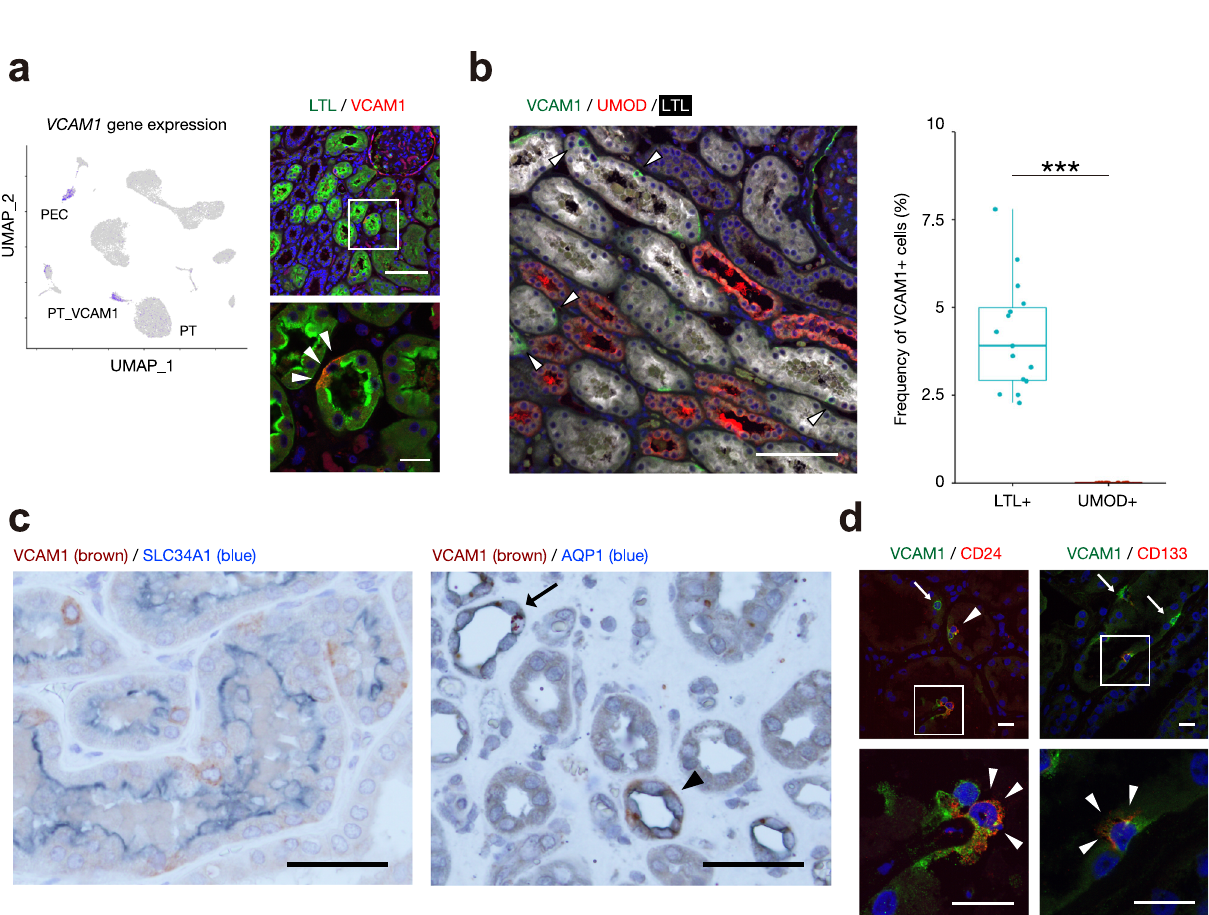
Fig. 5 Identi fi cation of a subset of proximal tubular cells that express VCAM1 . a Umap plot displaying VCAM1 gene expression in the snRNA-seq dataset (left), and representative immunohistochemical images of VCAM1 (red) or LTL (Lotus tetragonolobus lectin, green) in the adult kidney ( n = 3 patients). Arrowheads indicate the VCAM1 + proximal tubular cells. VCAM1 was expressed in PEC and a subpopulation of LTL + proximal tubular cells. Scale bar indicates 100 µ m (upper right) or 20 µ m (lower right). b Immuno fl uorescence staining for VCAM1 (green), UMOD (red) and LTL (white) in the adult human kidney sections (left, representative image) and quantitation of VCAM1-positive cells on the LTL-positive cells or UMOD-positive cells (right). The quanti fi cation was performed in fi ve 200x images randomly taken from each patient ( n = 3 patients). Arrowheads indicate VCAM1-positive cells in the LTL-positive PT. Scale bar indicates 100 µ m. Box-and-whisker plots depict the median, quartiles and range. *** P <0.001 ( P = 5.47×10 − 11 , two-sided Student ’ s t test). c Representative immunohistochemical images of SLC34A1 or AQP1 (blue) and VCAM1 (brown) in the adult human kidneys. An arrowhead marks VCAM1 expression in the DTL and an arrow marks DTL without VCAM1 expression. Scattered brown dots are seen with multiple different antibodies and considered non-speci fi c staining. Scale bar indicates 50 µ m. n = 3 samples were independently analyzed and similar results were obtained. d Representative immunostaining images of CD24 or CD133 (red) and VCAM1 (green) in the adult human kidney. Arrowheads indicate VCAM1 co-expression with CD24 or CD133 in PT and arrows mark VCAM1 expression without CD24 or CD133. Scale bar indicates 20 µ m. n = 3 samples were independently analyzed and similar results were also observed that CD24 + or CD133 + cells are rare in the VCAM1- proximal tubular cells. These fi ndings indicate that the PT_VCAM1 cluster is heterogeneous and may represent an injured or regenerative subpopulation of cells.